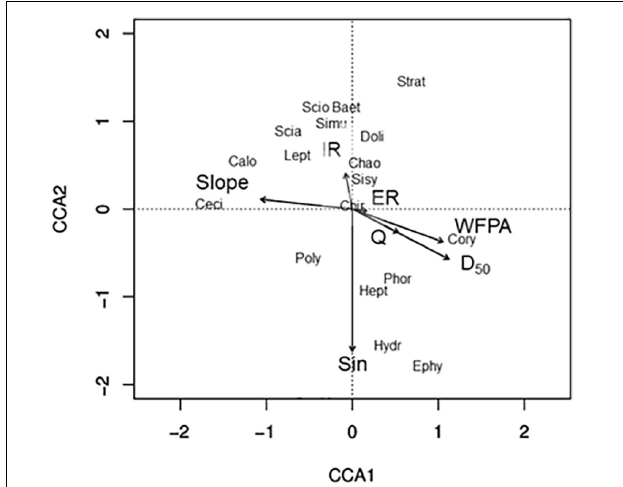
FIGURE 2 | Ordination biplot based on canonical correspondence analysis of seven hydrogeomorphic variables that minimized variance inflation factors and the relative abundance of emergent aquatic insect families. CCA1 and CCA2 explained 20.53 and 19.54% of the variation in emergent aquatic insect assemblages, respectively. Only the nine most common and nine rarest emergent-insect families are shown. Strat, Stratiomyidae; Baet,